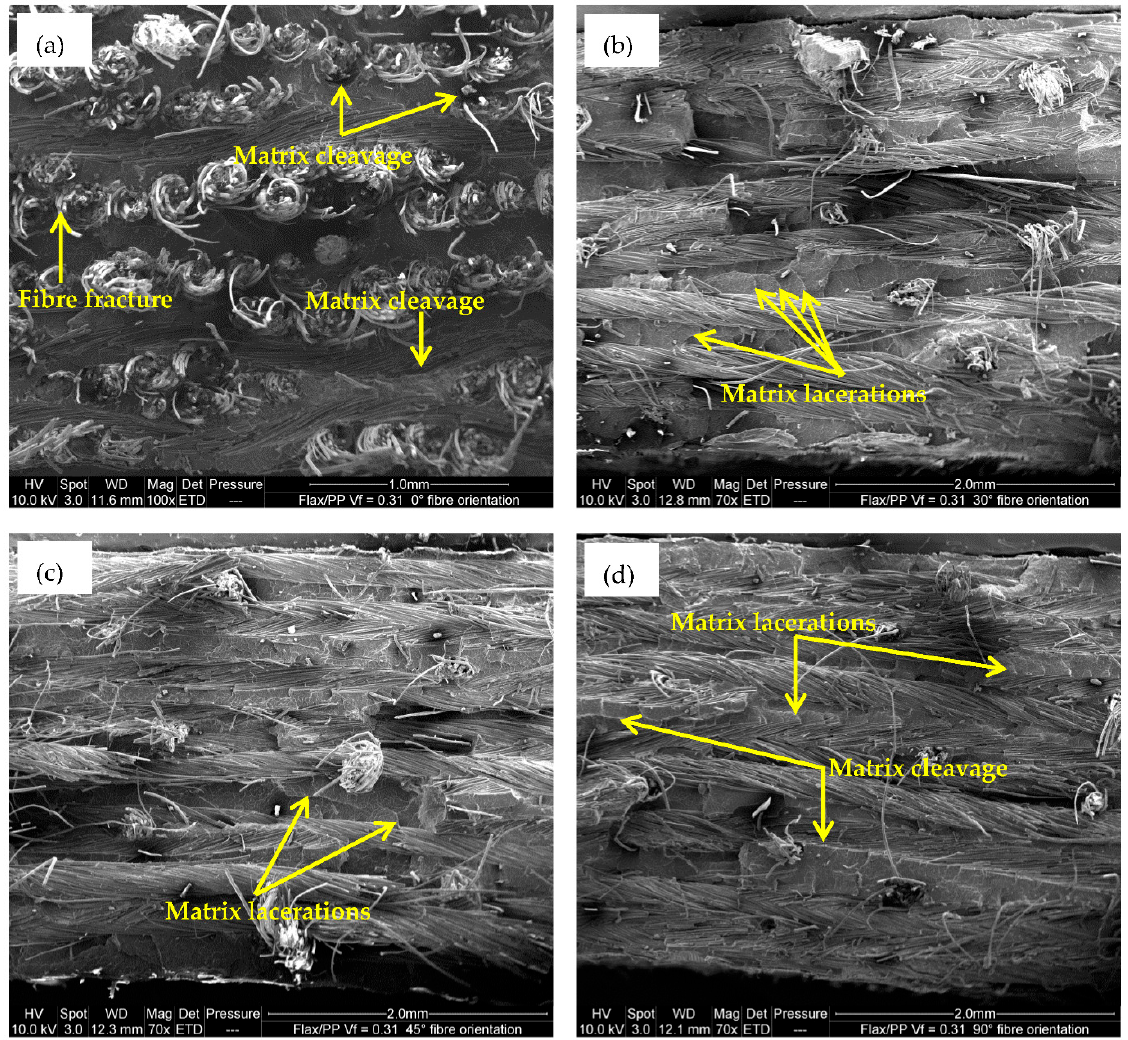
Figure 20. Tensile fracture surfaces of flax/PP composites with fibre orientations of ( a ) 0°, ( b ) 30°, ( c ) 45°, and ( d ) 90°.